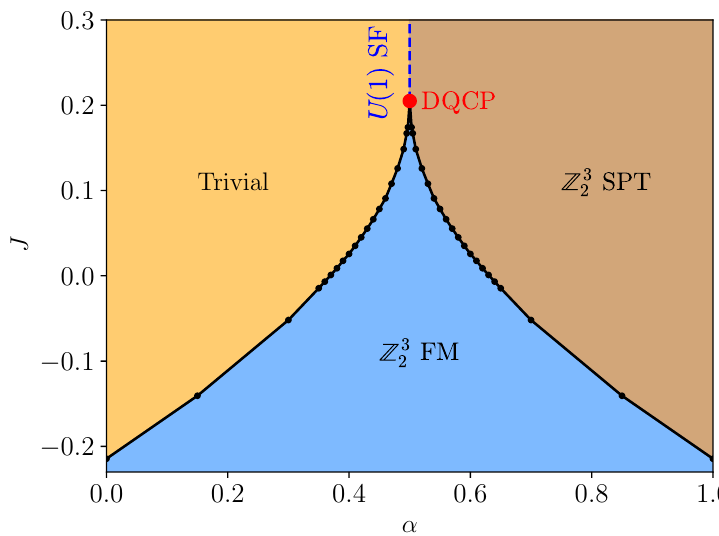
Figure 2: Phase diagram of the (cid:90) 3 SPT model on the triangular lattice (6), perturbed 2 by a trivial paramagnet (horizontal direction) and a same-sublattice Ising coupling (vertical direction). The central vertical axis has an exact U ( 1 ) pivot symmetry gen- erated by a three-site interaction (2), which has a mutual anomaly with the (cid:90) 3 sym- 2 metry (1). Each black dot along the phase boundary was obtained by determining the Binder ratio crossing of the ferromagnetic (FM) order parameter. The trivial and SPT phases are separated by either an intermediate FM phase (blue shaded region) or a first order transition (which is a superfluid (SF) for the U ( 1 ) pivot symmetry). We argue that these two phases meet at a multicritical point which is described by the SO ( 5 ) DQCP (red dot), where α and J correspond to perturbing with the monopole and mass operators, respectively. The J = 0 line was studied in Ref. [ 60 ]